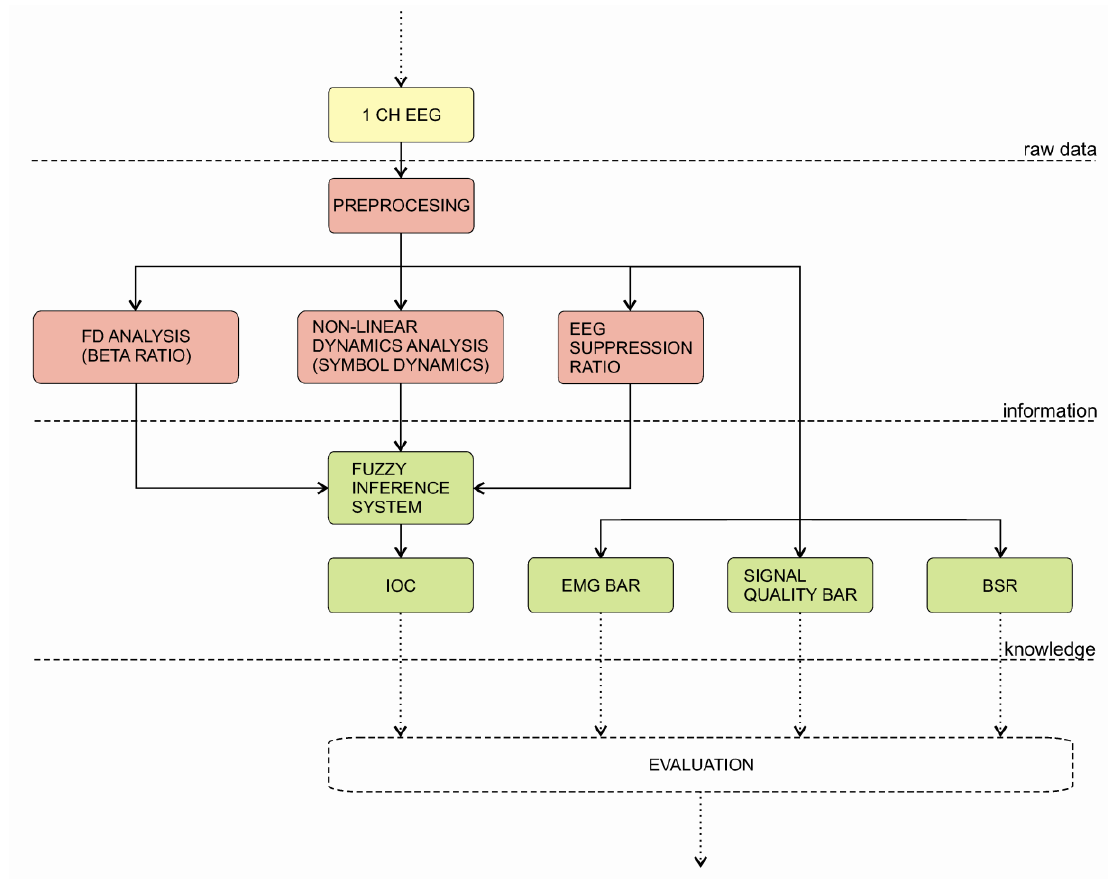
Figure 9. The block diagram of the IoC's algorithm. Abbreviations: BSR (burst suppression ratio), FD (frequency domain), electromyography activity